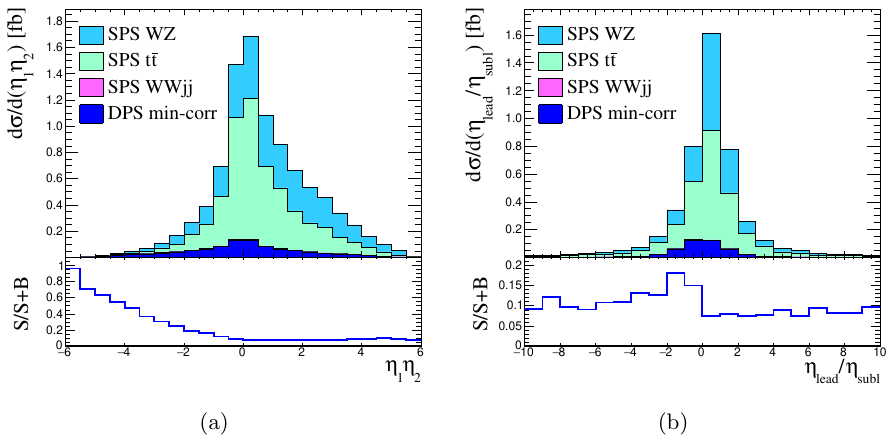
Figure 11 . The distributions based on muon rapidity has the highest signal-background discrim- inant power. Here, (a) shows the distribution of the product of the muon rapidities and (b) shows the ordered ratio of them, i.e. leading muon (cid:17) over the sub-leading muon (cid:17) .